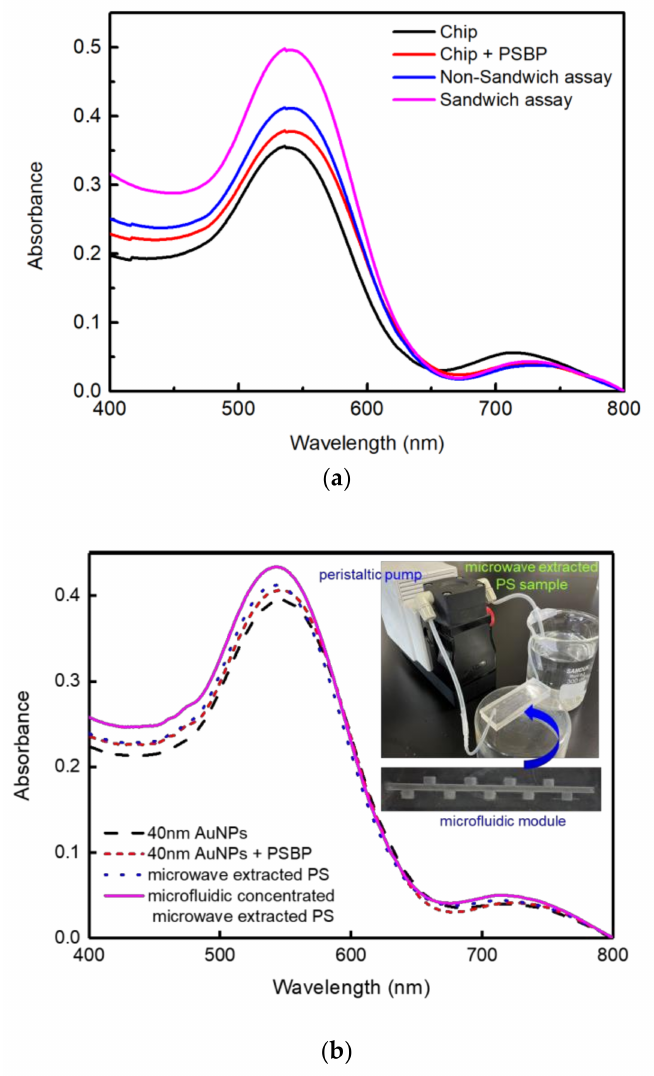
Figure 7. UV-Vis absorption spectra with microwave-boiled DI water in styrofoam bowl for the sandwich assay sensor chip with 5 nm Au NPs: ( a ) pristine styrofoam-derived nanoplastic sample, ( b ) concentrated styrofoam derived nanoplastics in PDMS microfluidic trap